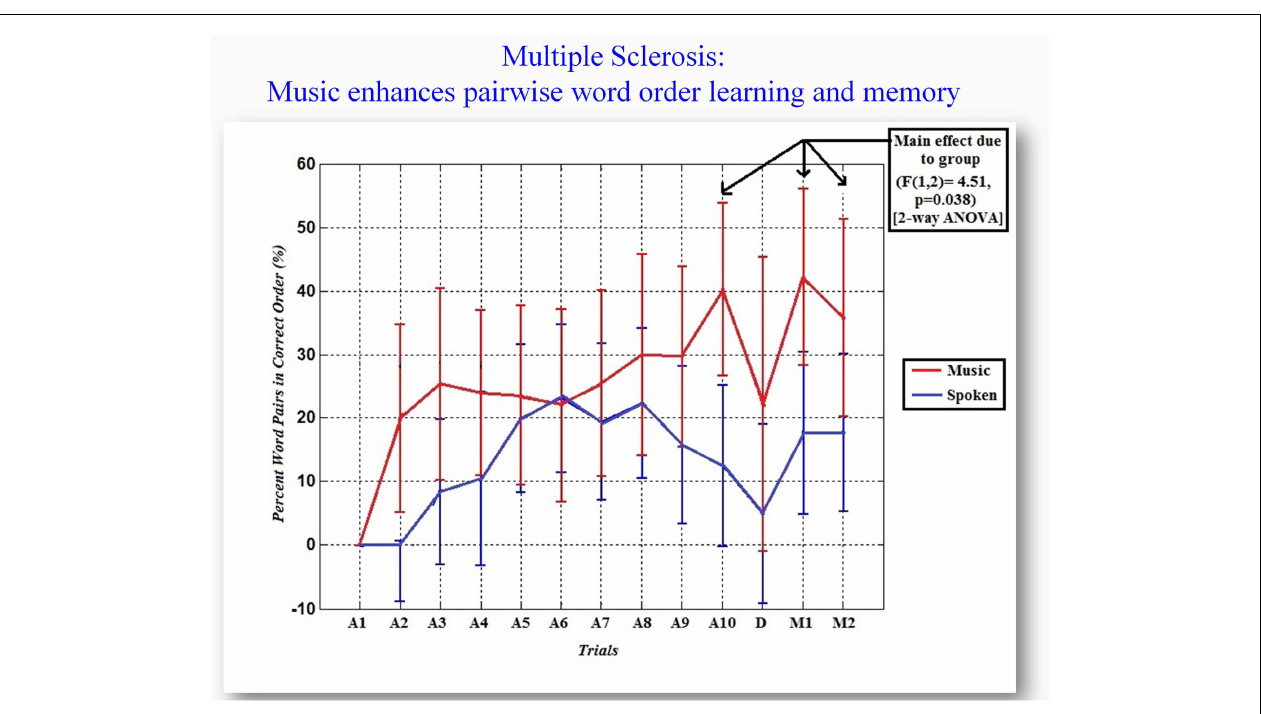
FIGURE 2 | Music enhances pair-wise word order learning and memory . X -axis: trial (learning trials 1–10, distractor trial “Dd,” and memory trials 1 and 2). The % of recalled word pairs in correct order ( Y -axis) is the change relative to trial 1. Bars are standard error.